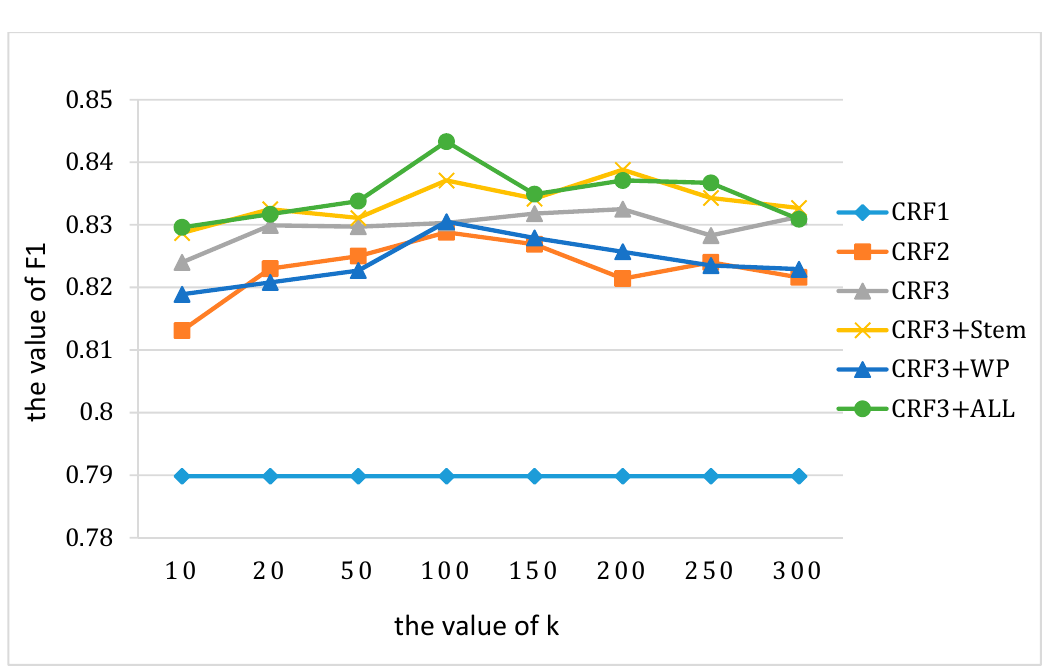
Figure 4. The effect of K on experimental results (L-14).